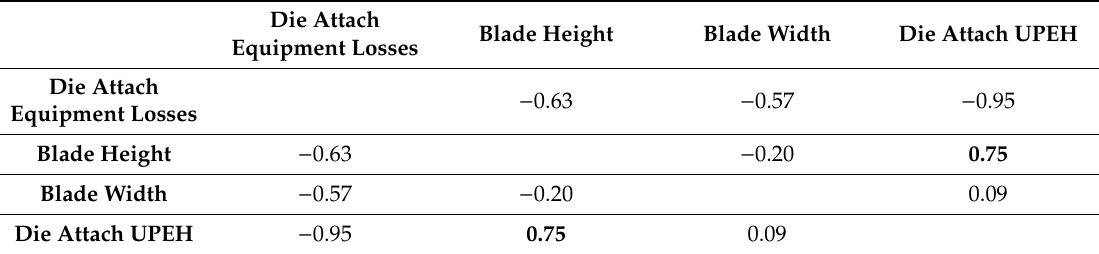
Figure 10. Scatter plots of four factors (parameters): (i) The number of losses (due to equipment fault, i.e., unexpected stoppage) that occurred in the die attach process equipment, (ii) the blade height of the wafer sawing process equipment, (iii) the blade width of the wafer sawing process equipment, and (iv) UPEHs of the die attach process equipment. Table 7. Correlation coe ffi cients matrix of four factors (parameters) of die attach process equipment and wafer sawing process